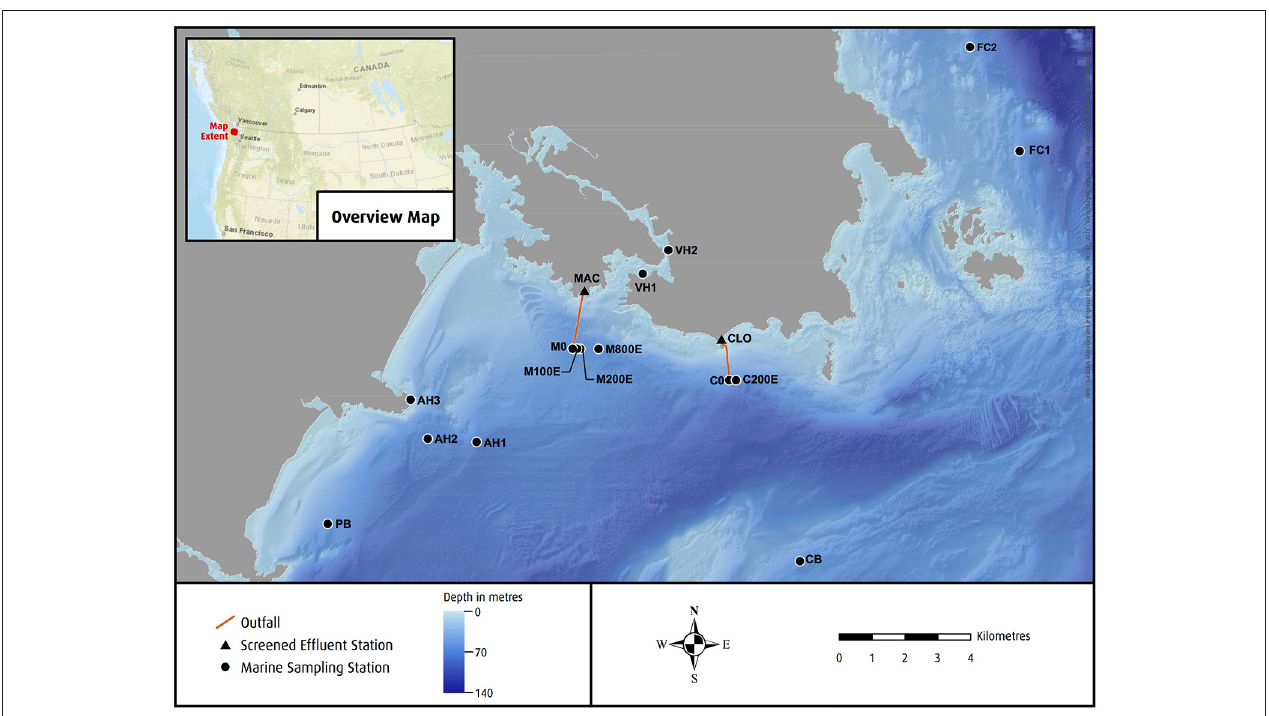
FIGURE 1 | Map of the study area with all sampling locations marked.